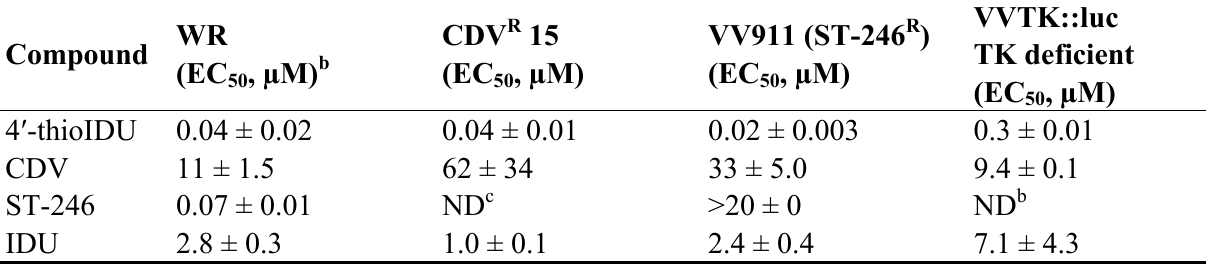
Table 4. Activity of 4 ′ -thioIDU Against Resistant Mutants of Vaccinia Virus a .